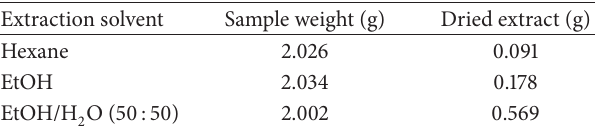
Table 1: Different extraction conditions of B. orellana seed powder for mosquito repellency evaluation.